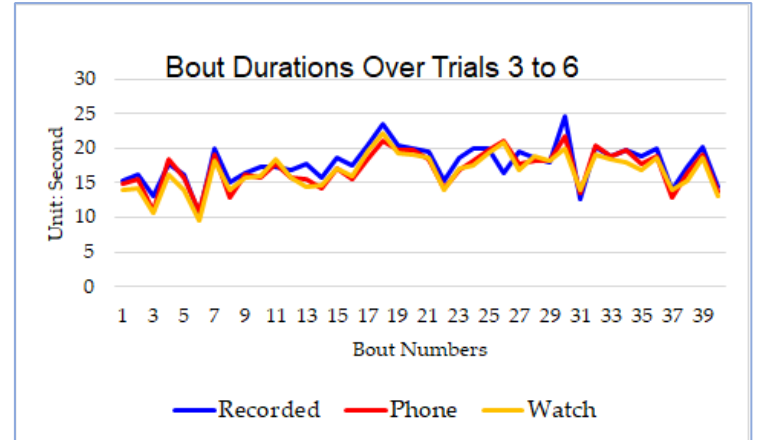
Figure 8. Bout durations over Trials 3 to 6. Table 2. Results for the first experimental series (unit: s).